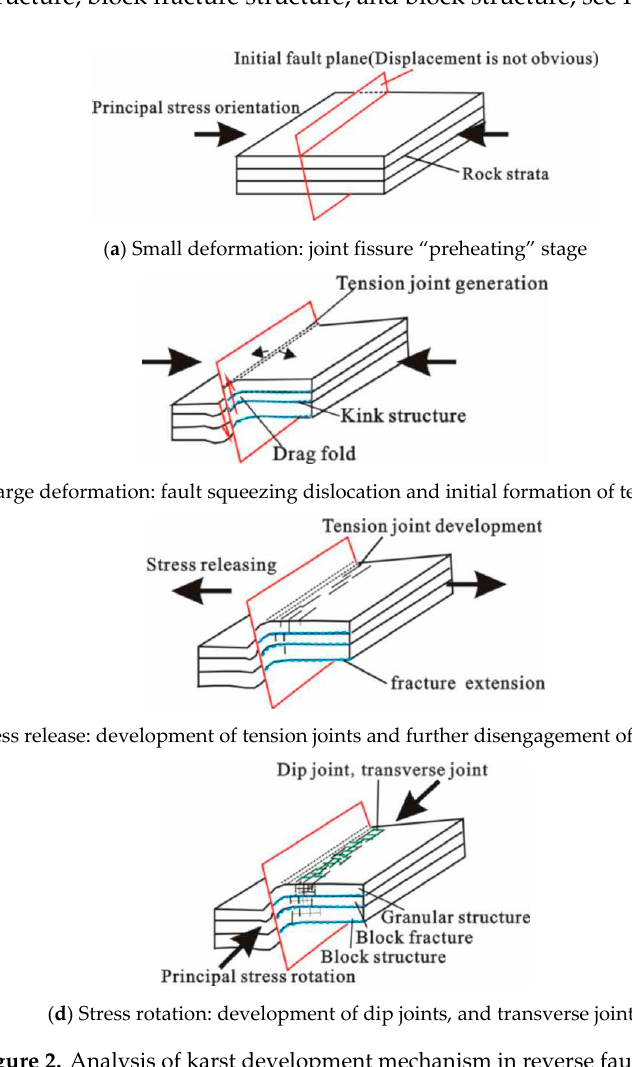
Figure 2. Analysis of karst development mechanism in reverse fault control.